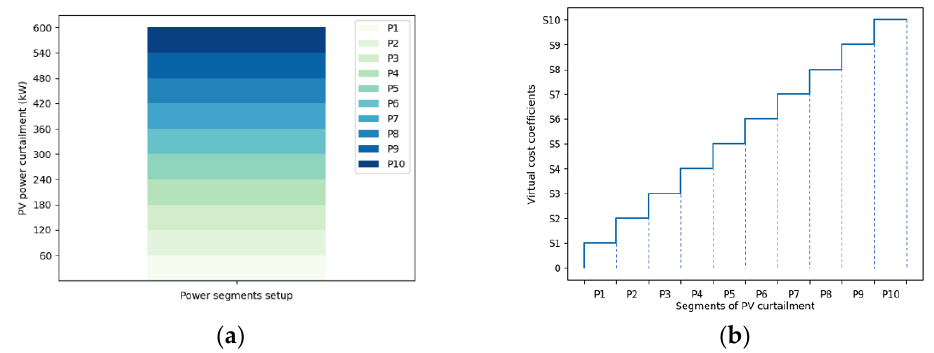
Figure 3. ( a ) PV power curtailment interval setting and ( b ) differential cost coefficients.